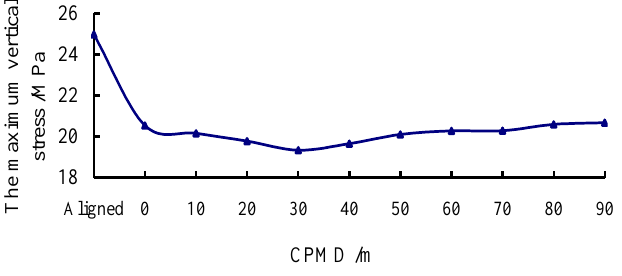
Figure 9. Maximum vertical stress vs. CPMD.